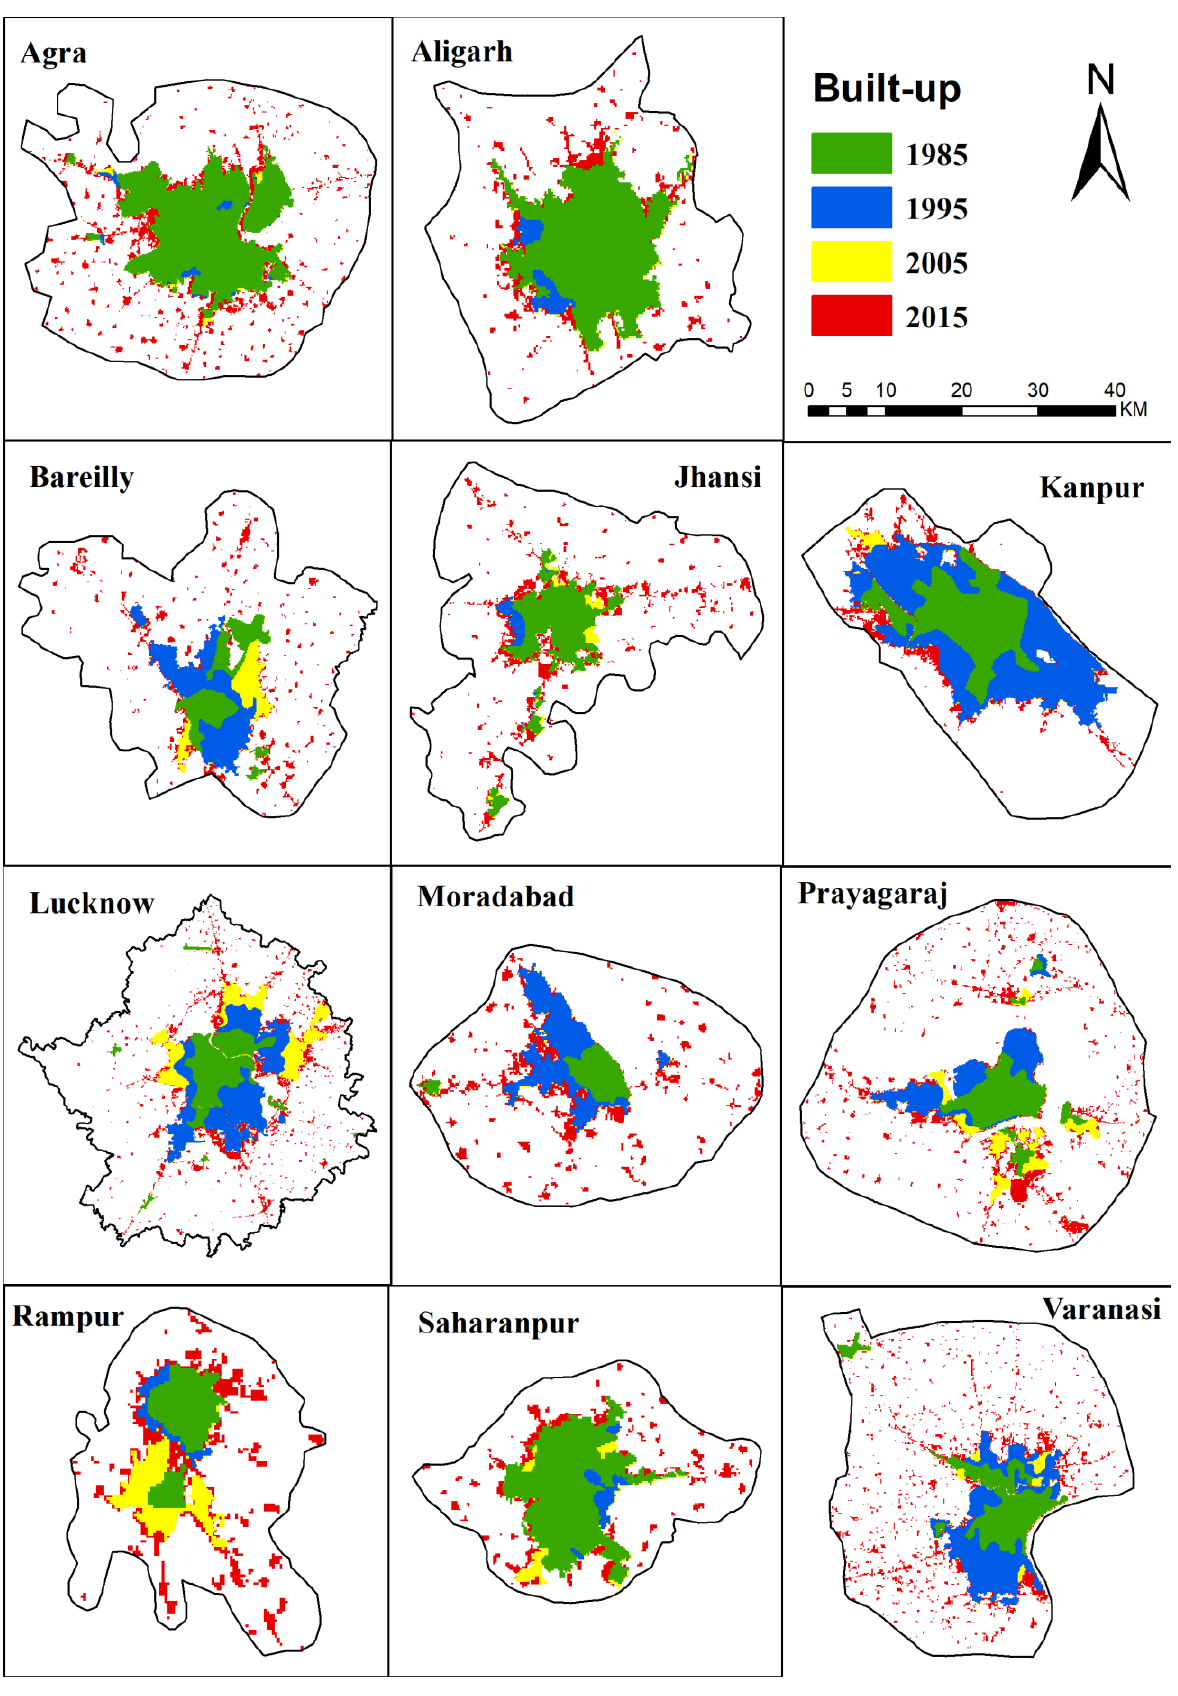
Figure 4. Urbanisation of 11 smart cities over